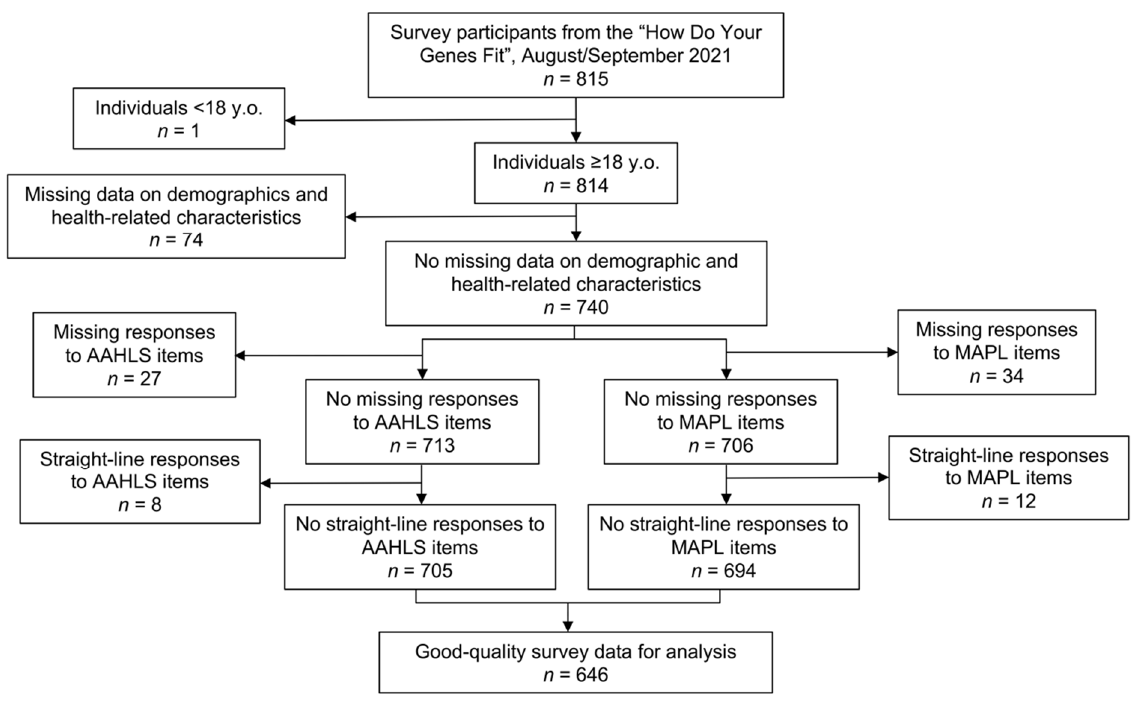
Figure 1. Study flowchart.